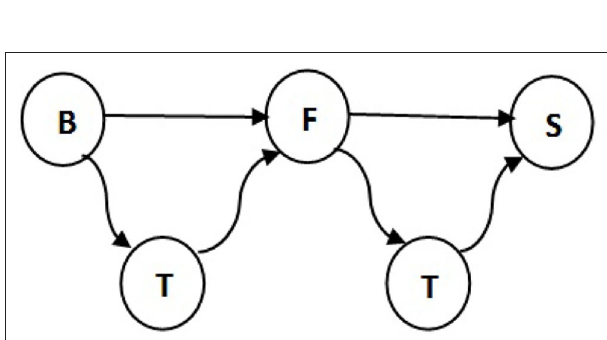
FIGURE 5 | Transmissions between different farm types in the pig trade network. B, F, T, and S indicate breeding farm, fattening farm, trader, and slaughterhouse,